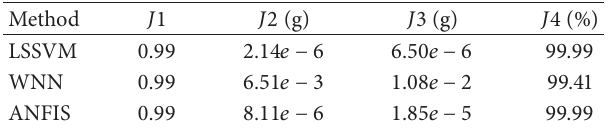
Table 2: Statistical analysis of the development